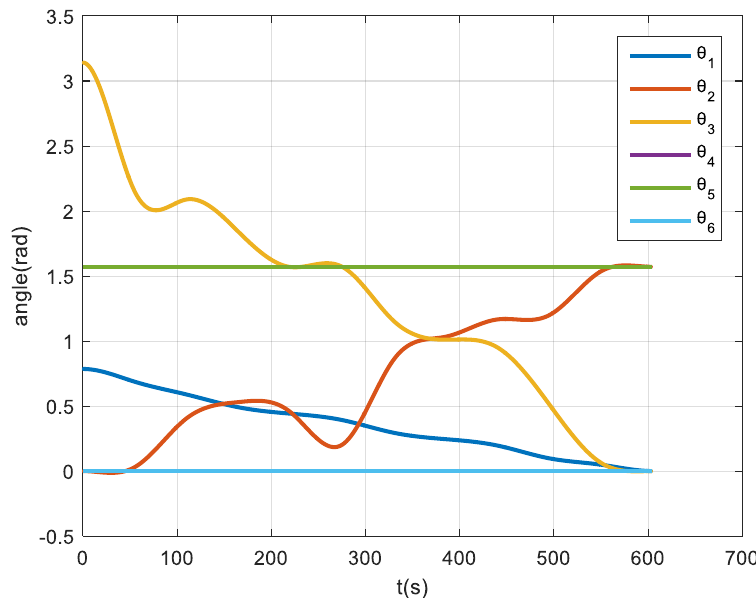
Figure 12. Manipulator trajectory planning results.